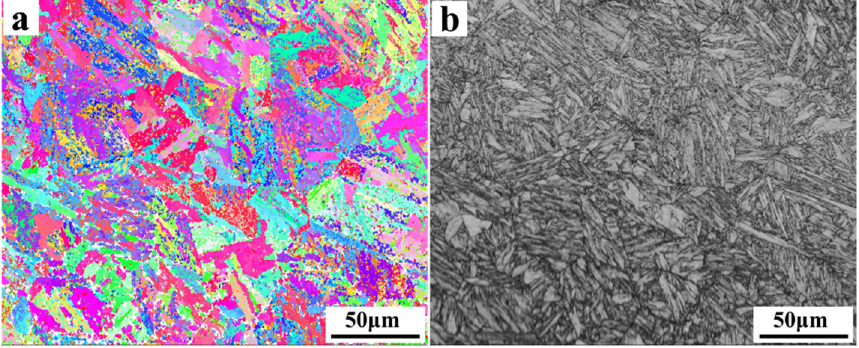
Figure 1. ( a , b ) EBSD diagram of raw materials. Table 1. Chemical composition of M50NiL steel